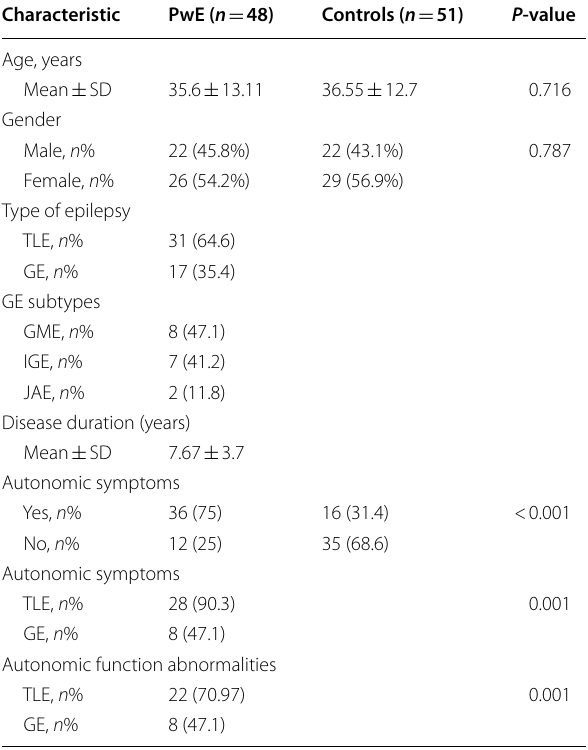
Table 1 Demographic baseline data of the study